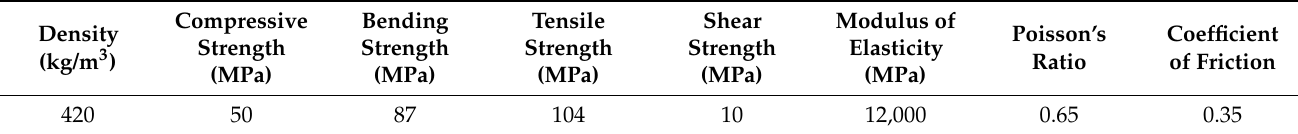
Table 1. Mechanical properties of smooth grain pine